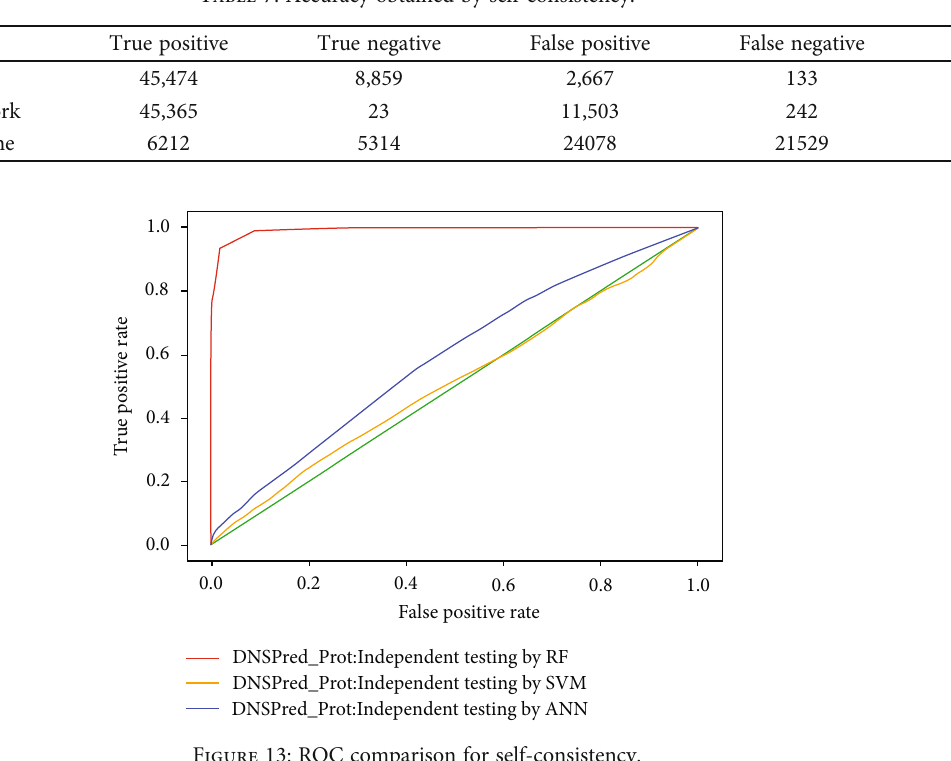
Figure 12: ROC of independent testing by classi fi ers. Table 7: Accuracy obtained by self-consistency.